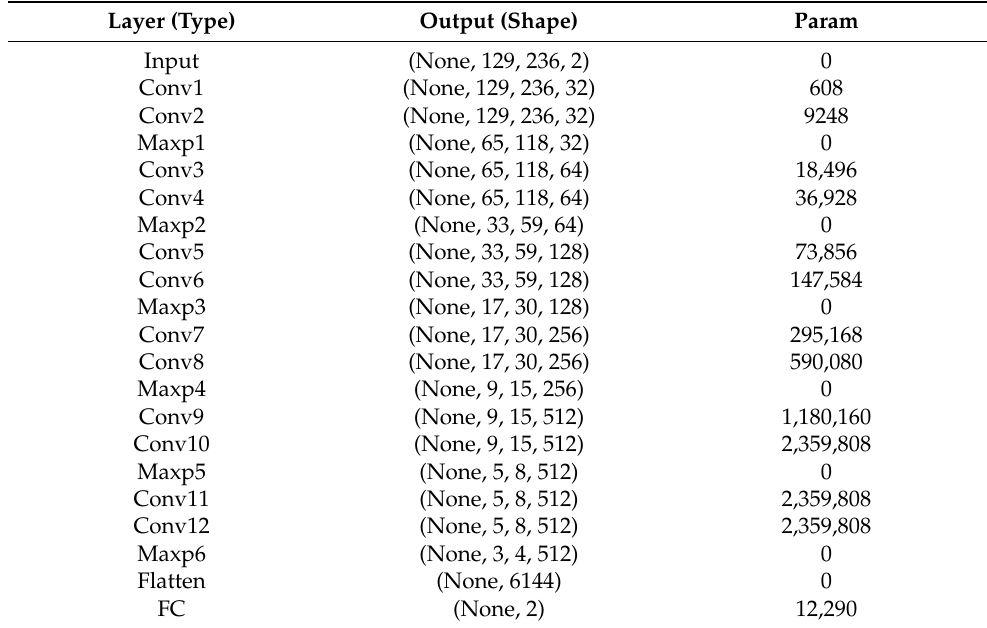
Table 1. Parameters of the TFMC